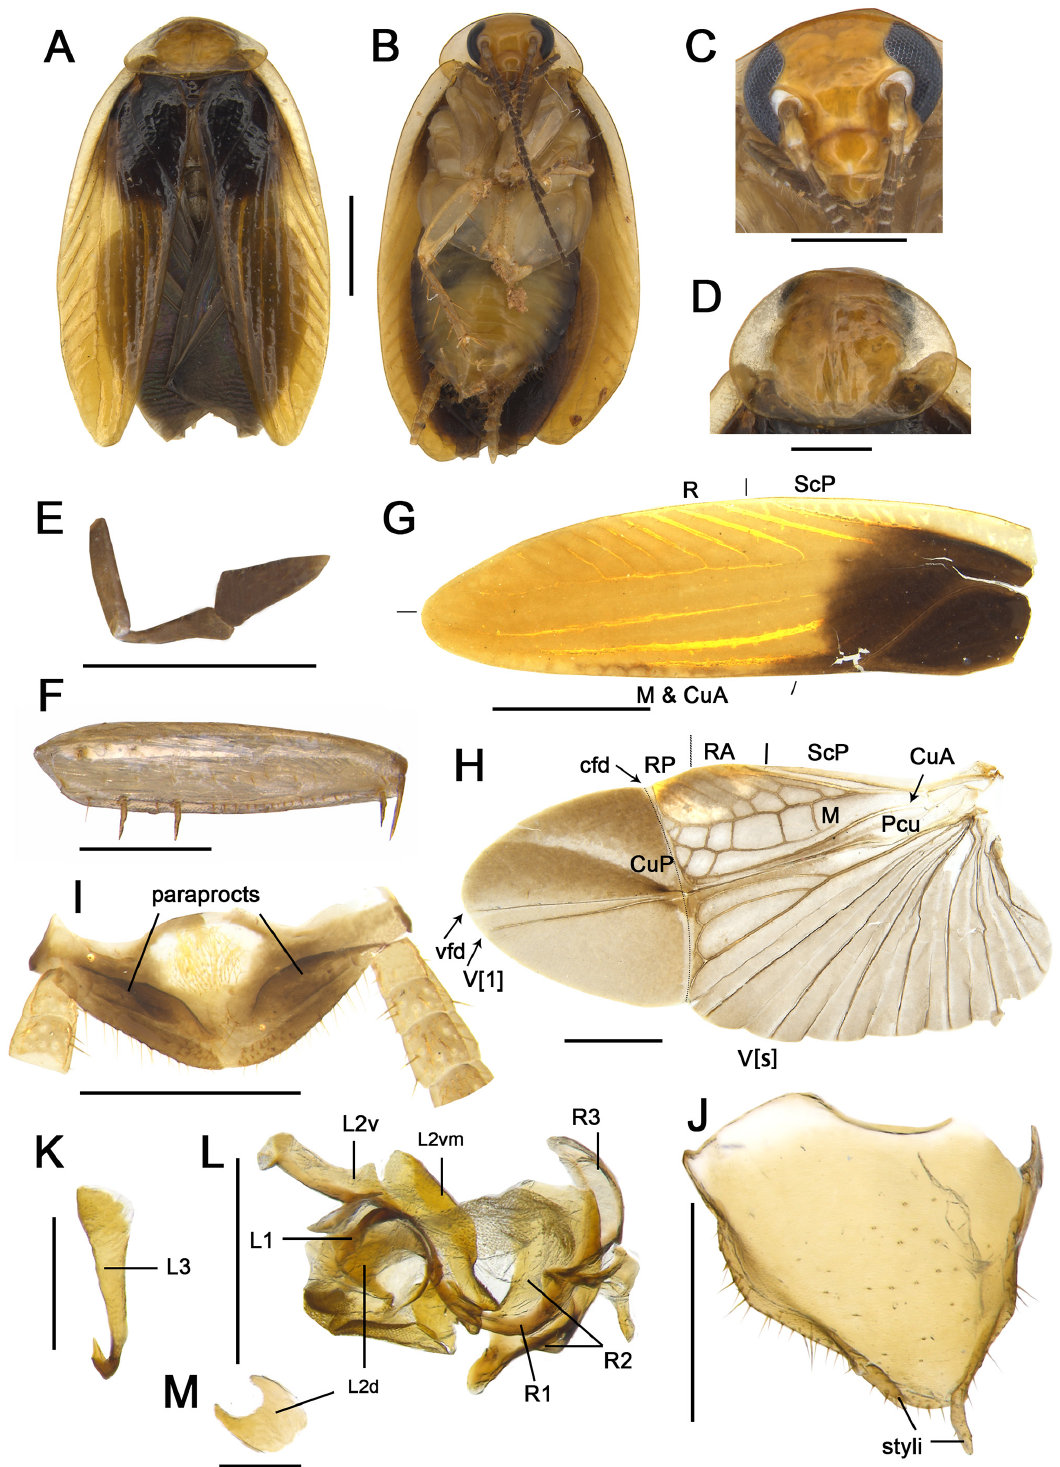
Fig. 8. Anaplecta nigra Deng & Che sp. nov., holotype, ♂ (SWU). A . Habitus, dorsal view. B . Habitus, ventral view. C . Head, ventral view. D . Pronotum, dorsal view. E . Maxillary palp. F . Front femur, ventral view. G . Tegmina. H . Wings. I . Supra-anal plate, dorsal view. J . Subgenital plate, ventral view. K . Hook, ventral view. L . Left and right phallomeres, ventral view. M . L2d. Scale bars: A–D = 1 mm; E–J, M = 0.5 mm; K–L = 0.25